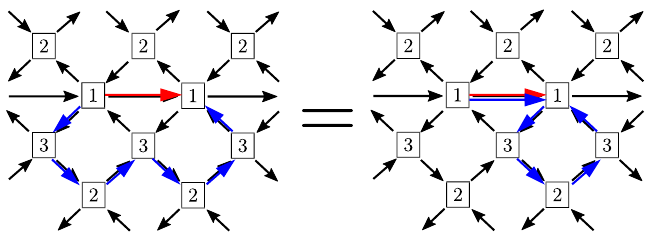
Figure 5. Identification on periodic quiver diagrams. The red path is the shortest path connecting such two points. The two blue paths are identified by the F-term relation, and they are the red shortest path plus one loop.